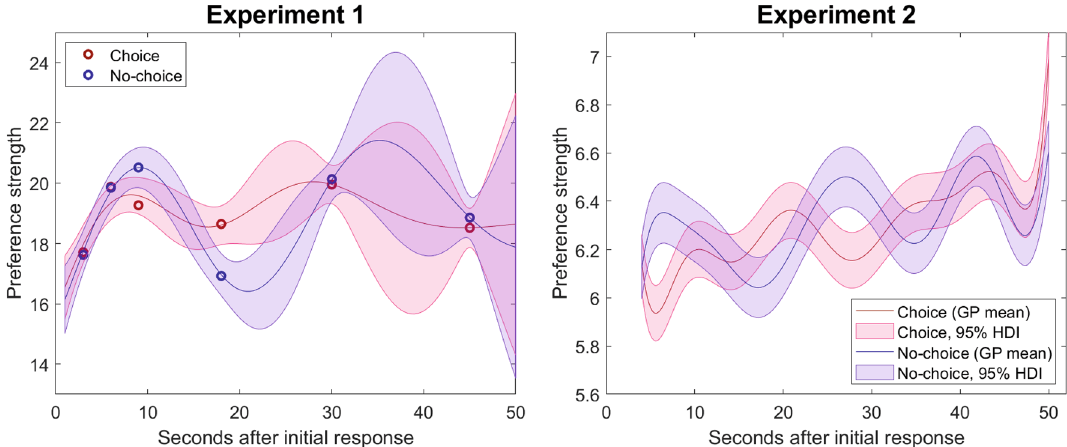
Figure 2. Plot of Gaussian process regression, which estimates the best functions mapping time point (x-axis) onto mean preference strength (y-axis). Filled areas indicate 95% most credible functions/error for choice (red) and no-choice (blue) conditions. Preference strength is on a 0–30 scale for Experiment 1 and 0–10 scale for Experiment